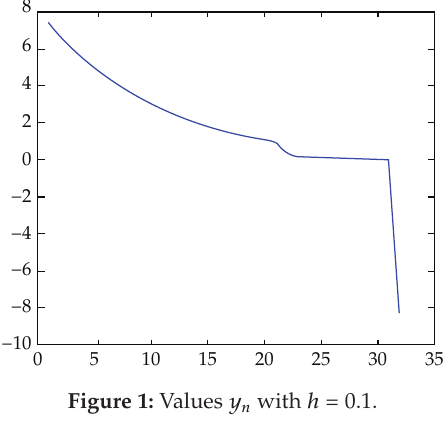
Figure 1: Values y n with h (cid:7) 0 . 1.